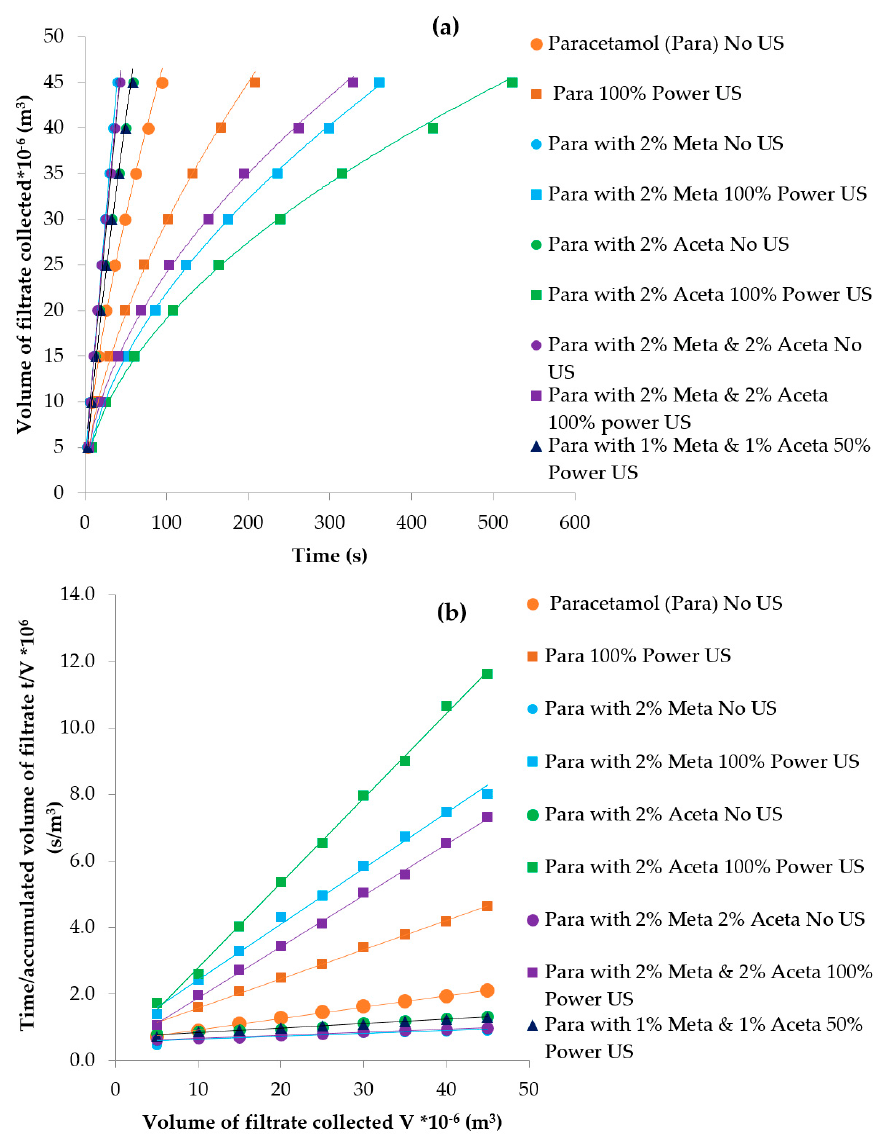
Figure 9. ( a ) Volume of filtrate collected versus time showing the filtration duration and filtration rate of ultrasound treated and non-ultrasound treated samples; ( b ) Plot of time/volume of filtrate collected (t/V) versus volume of filtrate (V) showing the ultrasound treated samples filter much more slowly and have correspondingly higher cake resistances (reported in Table 3) than the un-treated samples.